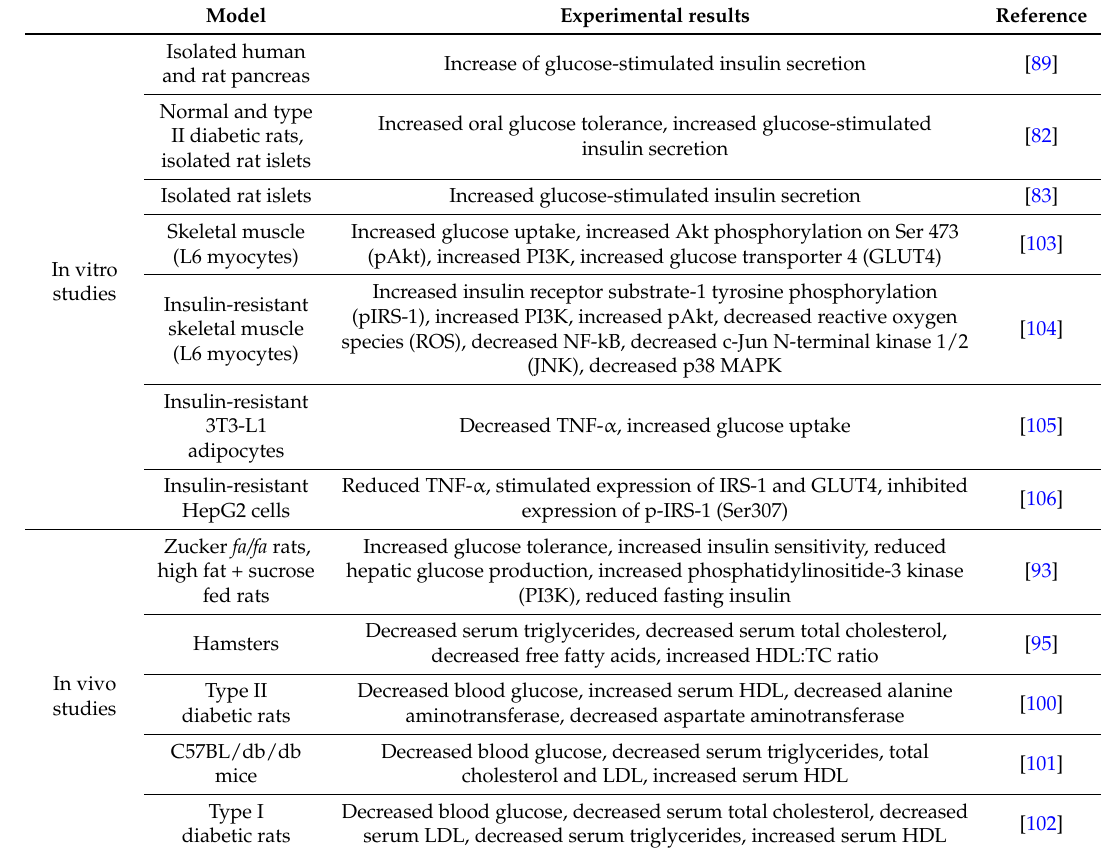
Table 1. Effects of 4-hydroxyisoleucine in insulin resistance and its adverse metabolic